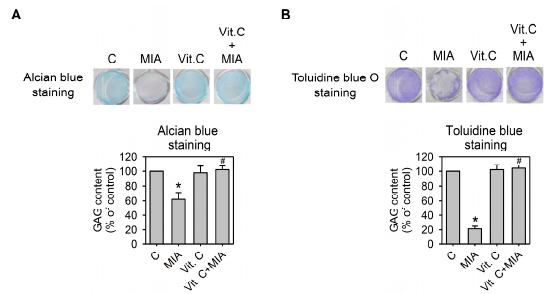
Figure 5. Effect of MIA and/or vitamin C on proteoglycan loss. SW1353 cells cultured in 24-well plates were incubated with 100 μ M vitamin C in the presence or absence of 5 μ M MIA for 24 h, and then the glycosaminoglycan (GAG) contents in the proteoglycan was determined by ( A ) alcian blue staining; or ( B ) toluidine blue O staining followed by colorimetric assay. The data of each down panel are expressed as the relative density compared to that in untreated cells (control), which was 100%. The results are the mean ± S.D. for three separate experiments. * p < 0.05 compared to the untreated control. # p < 0.05 compared to the MIA treated group.